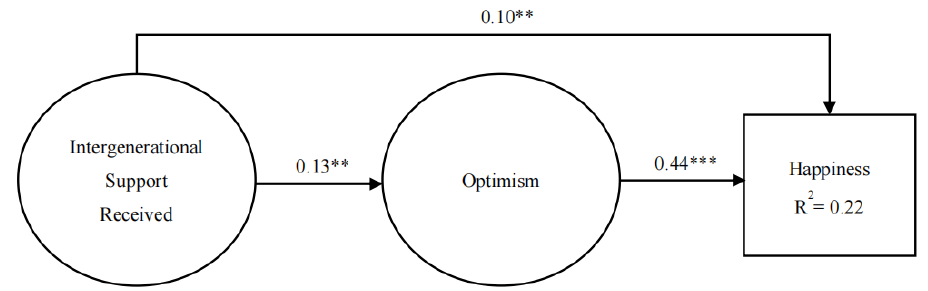
Figure 1. Overall model. Note . *** p < 0.001; ** p < 0.01.